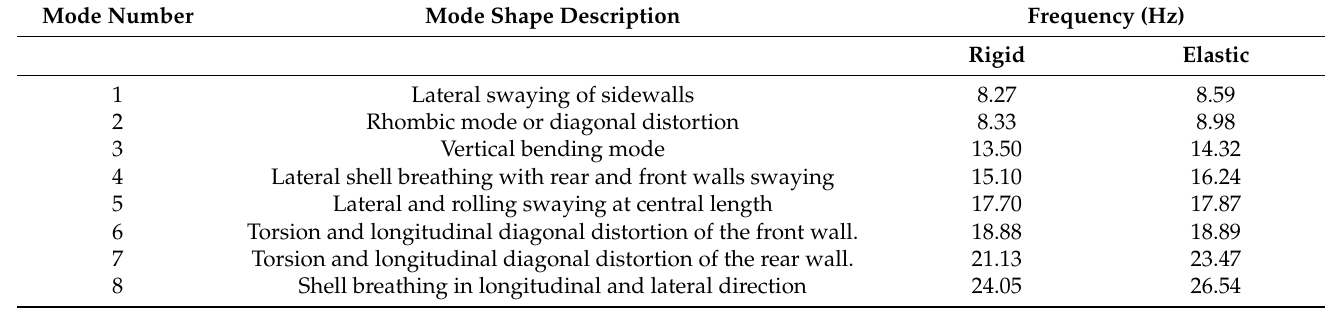
Table 2. Comparison of modal frequency in terms of rigid and elastic car body.